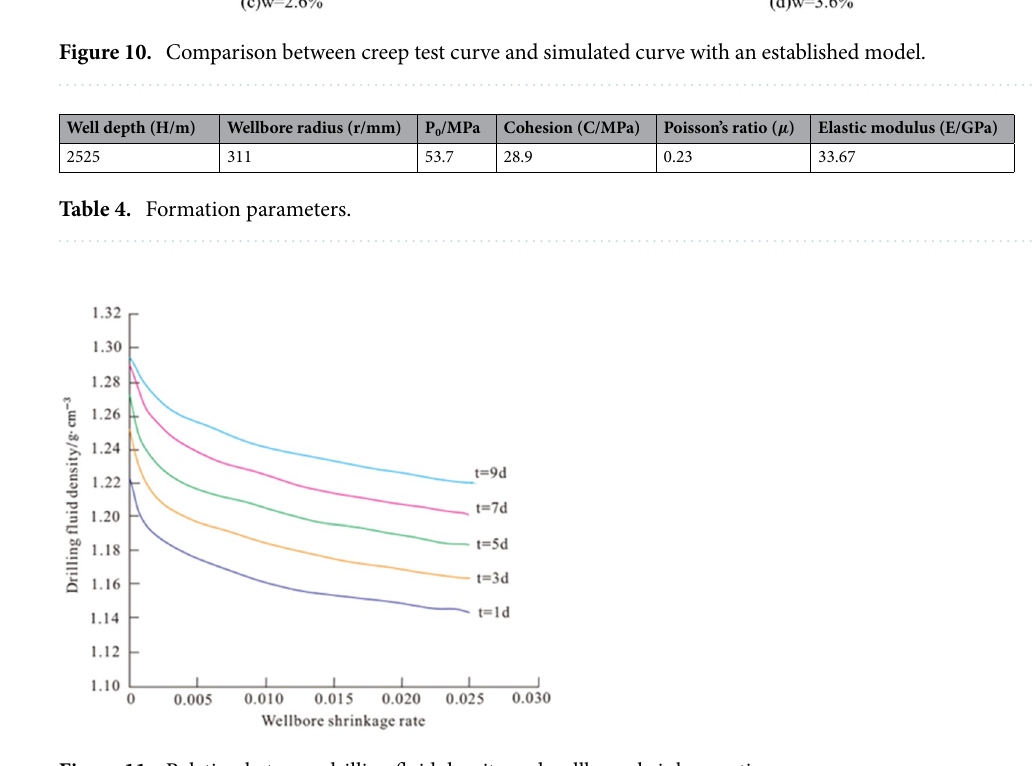
Figure 11. Relation between drilling fluid density and wellbore shrinkage